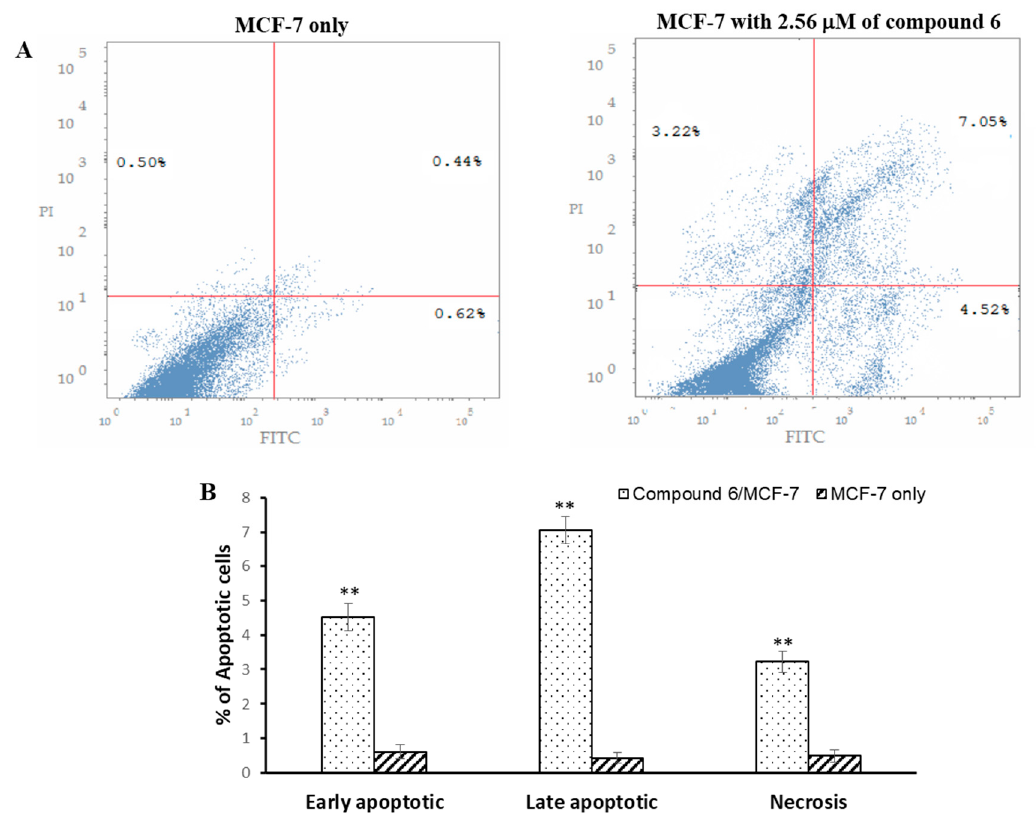
Figure 3. The apoptotic and necrotic cells obtained from MCF-7 cells alone or with compound 6 at a concentration of 2.56 μ M. ( A ) The flow cytometry results. ( B ) the percentage of the apoptotic cells. ** p ˂ 0.01 according to Tukey’s test.